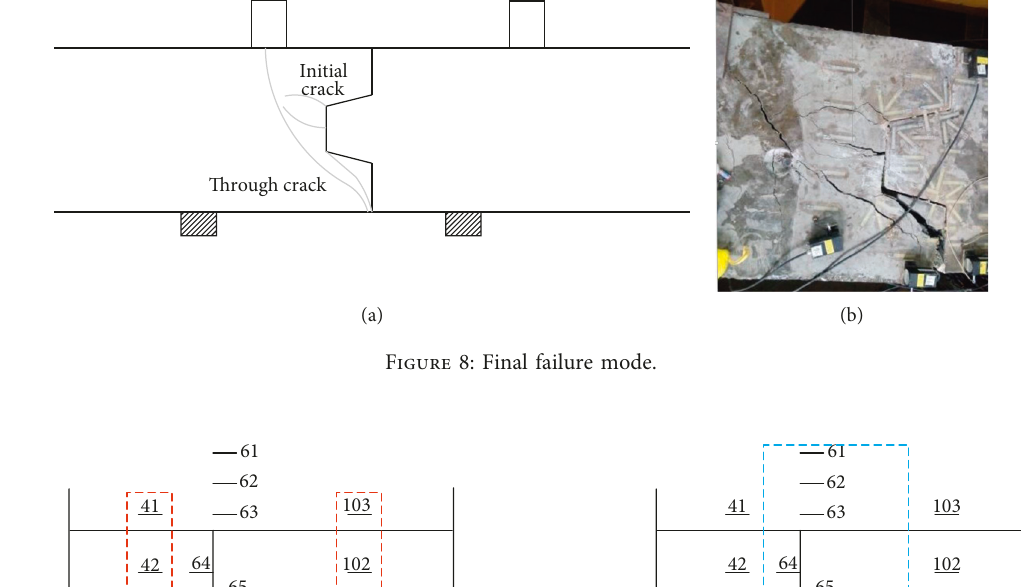
Figure 8: Final failure mode.